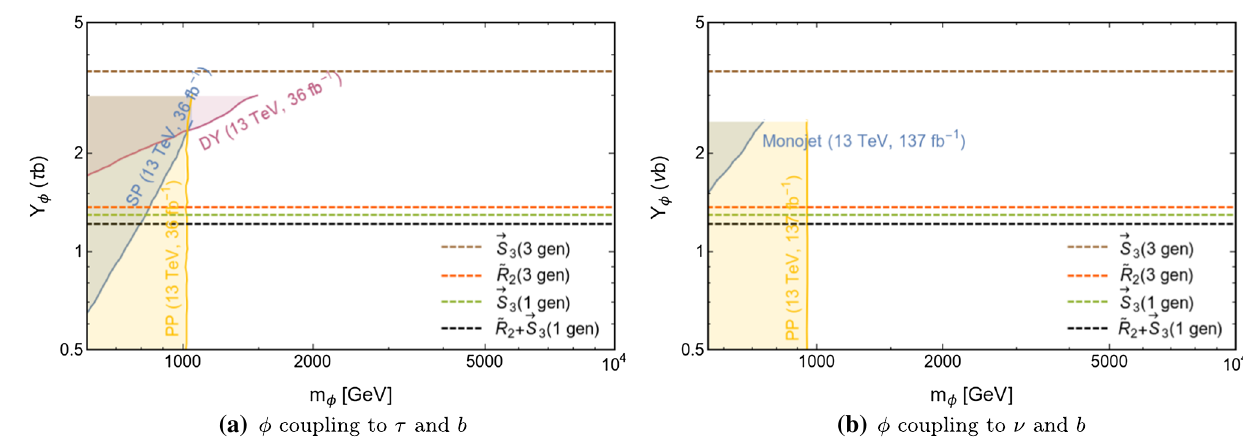
Fig. 21 Bounds on parameter space of scalar leptoquark coupling to third generation of quarks and leptons [91,156]. The shaded regions are disallowed by direct detection. The limit from pair production involv- ing charged leptons is recast from [163], which is shown in yellow. The limits emerging from single production (SP) and Drell–Yan (DY),